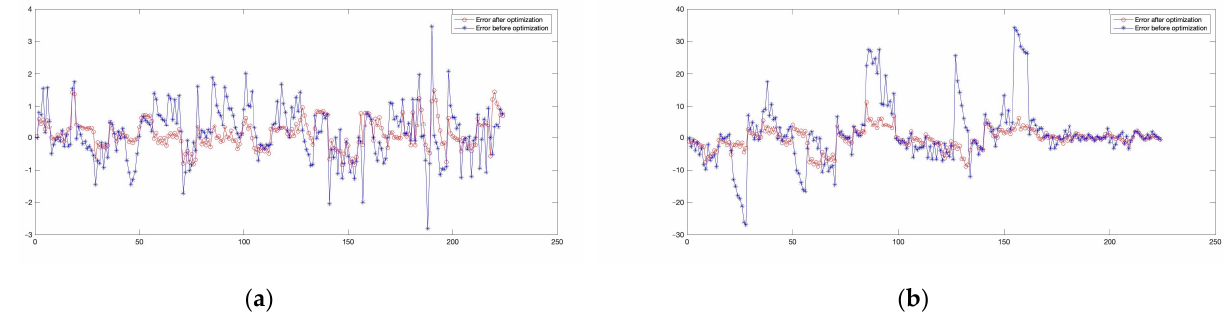
Figure 14. The comparison diagram of the prediction error of the BP neural network model and the CPA-BP model for the surface roughness (Ra ( a ) and Rmax ( b )) of plywood.